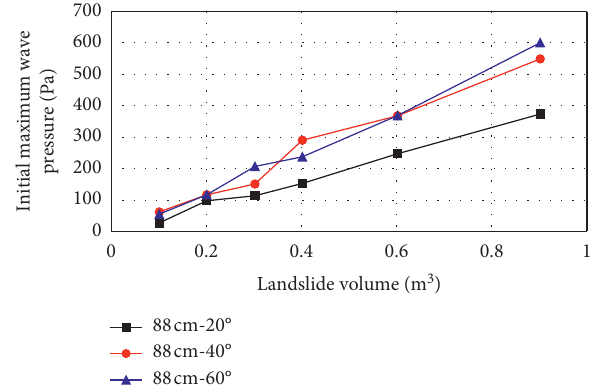
Figure 15: Variation of initial maximum wave pressure with landslide volume under different slope angles (at 88cm).